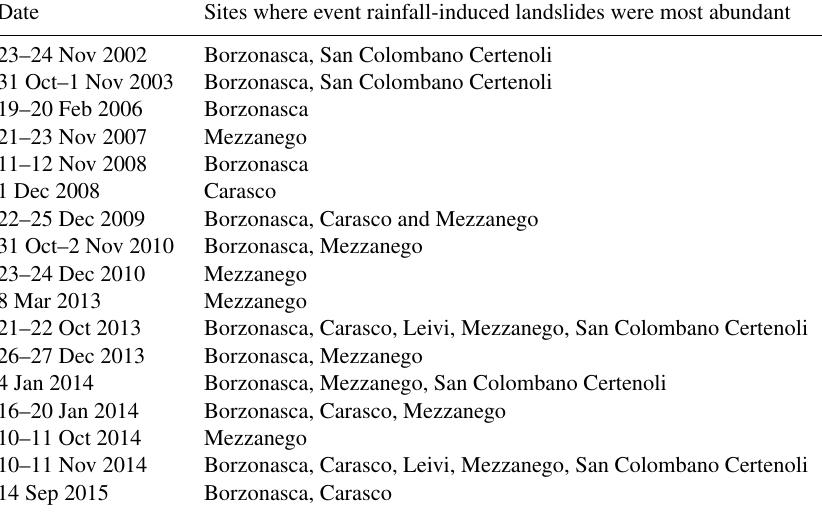
Table 5. Comparison between spatial distribution of the landslides used to define the rainfall threshold and the land-use setting in the Entella River catchment. Land-use category Number of Urban fabric 13 Complex cropland 4 Olive groves 7 Abandoned olive groves 2